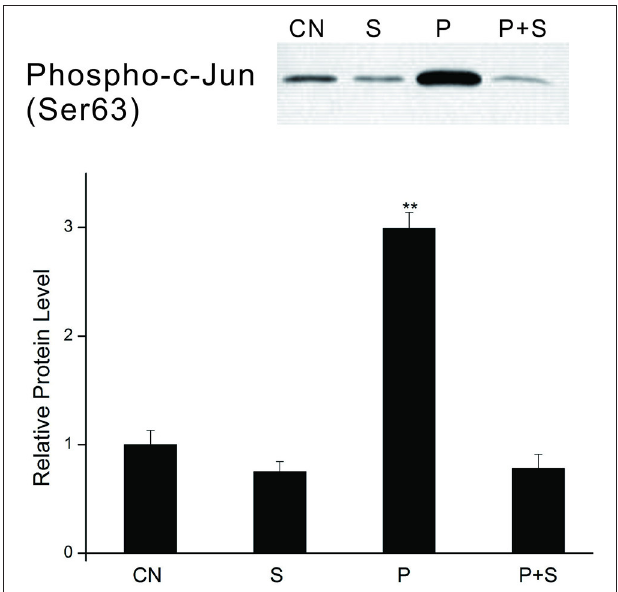
FIGURE 7 | Effects of SP600125 on the PTTH-stimulated kinase activity of JNK. PGs were pretreated with 20 µ M SP 600125 or vehicle alone for 30min, and then transferred to medium containing the same dose of SP600125, with or without the PTTH. Incubation was maintained for 60min. CN, glands incubated in control medium; S, glands incubated in medium containing 20 µ M SP600125 only; P, glands incubated in medium containing the PTTH only; P + S, glands incubated in medium containing both the PTTH and 20 µ M SP600125. In vitro kinase assays using c-Jun fusion protein beads were performed on gland lysates and subsequently analyzed by immunoblotting with an antibody to phospho-c-Jun. Results shown in the top panels are representative of three independent experiments. Data are expressed as multiples of change over the control. Asterisks indicate a significant difference compared to the control (by Student’s t -test, ** p < 0.01).